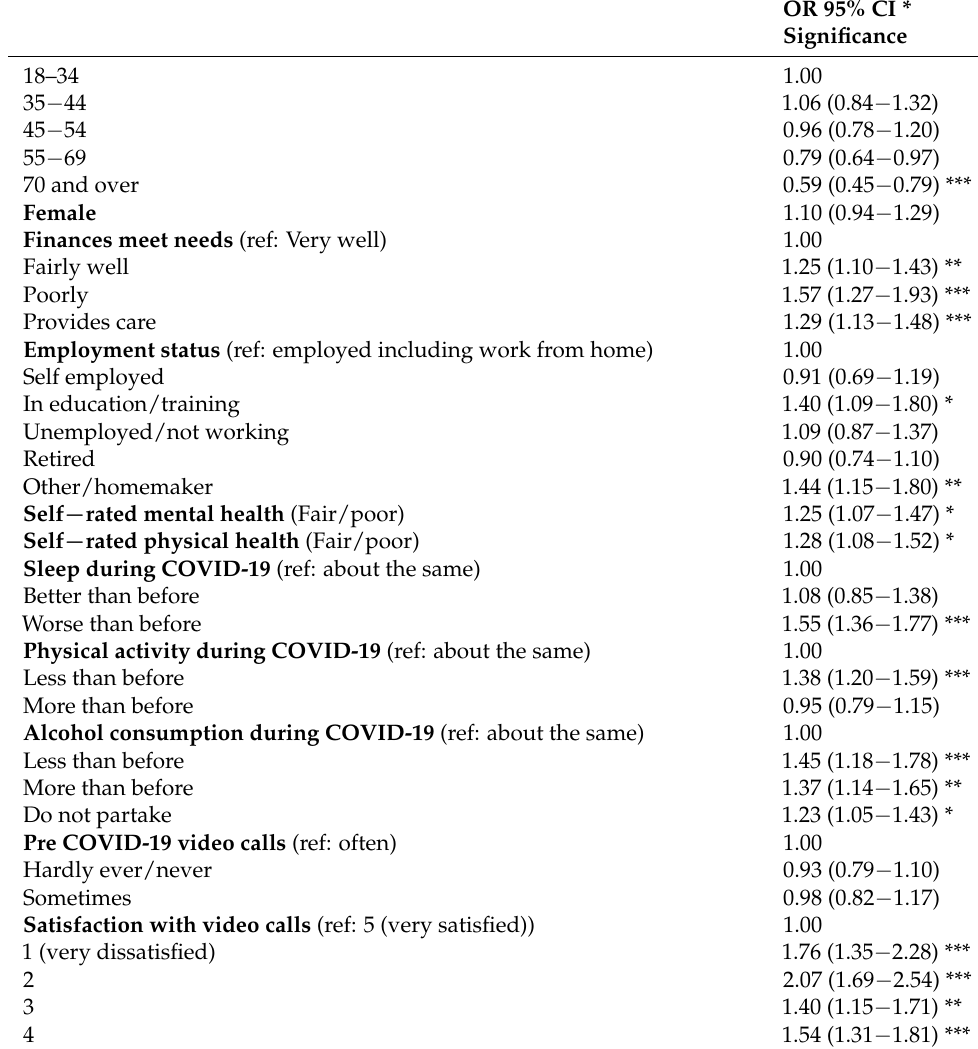
Table 5. Final logistic regression model for perceived large increase in isolation during